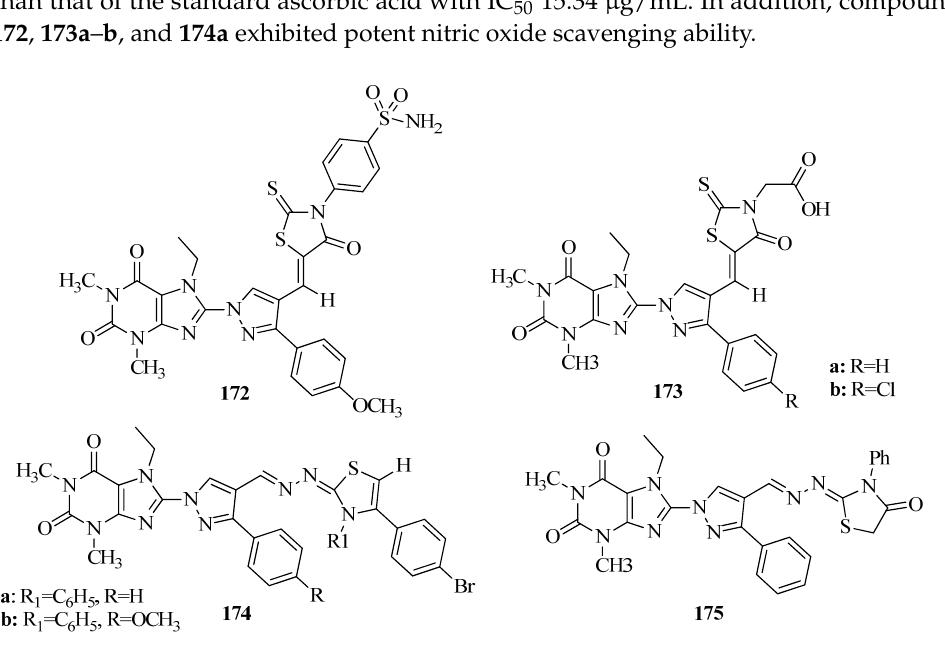
Figure 66. Structures of new 2-(2-((1H-indol-5yl)methylene)-hydrazinyl)–thiazoles ( 169a – f a; b; c; d; e; f; a; b; c; d; e; f; a; b; c; d; e; ), structures of compounds 170a , 170b , and 171.